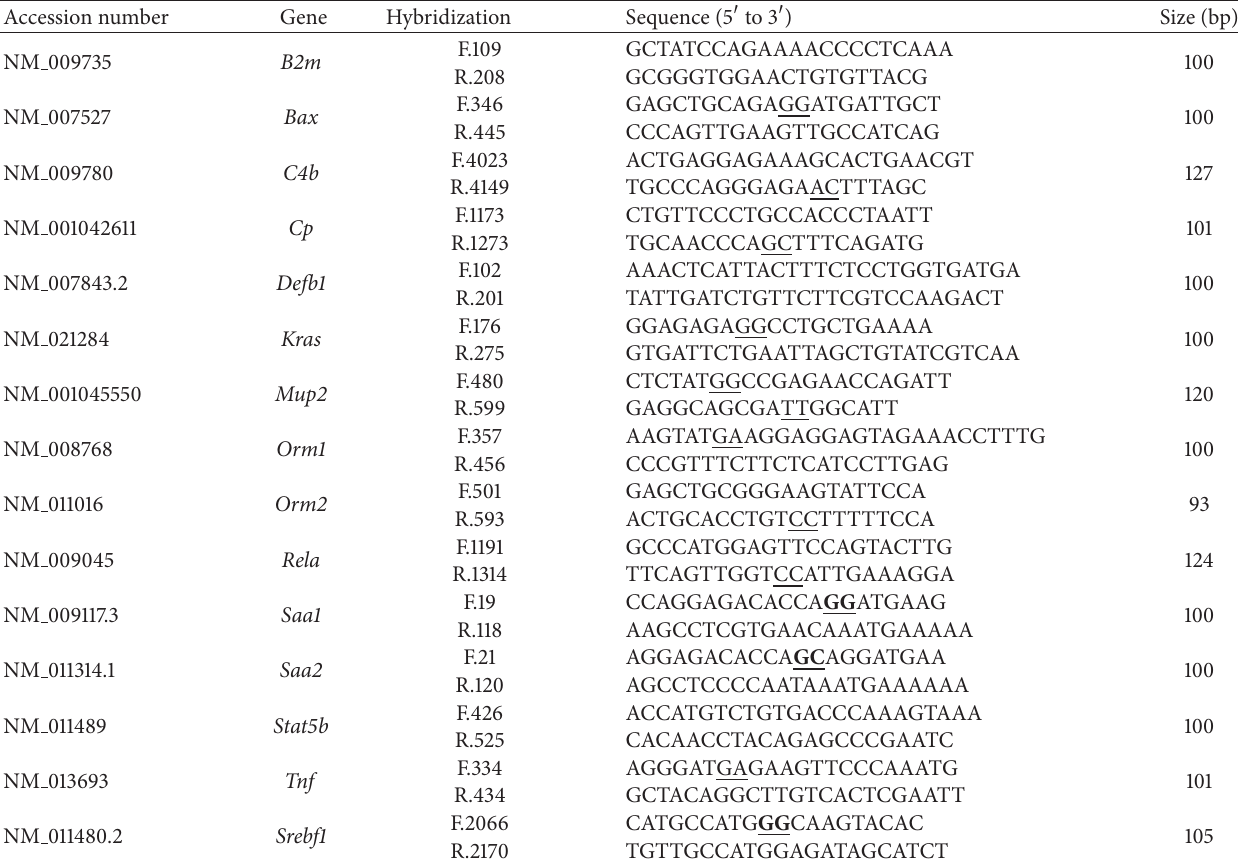
Table 1: Accession number, gene symbol, and primer sequences of target genes. Underlined are exon-exon